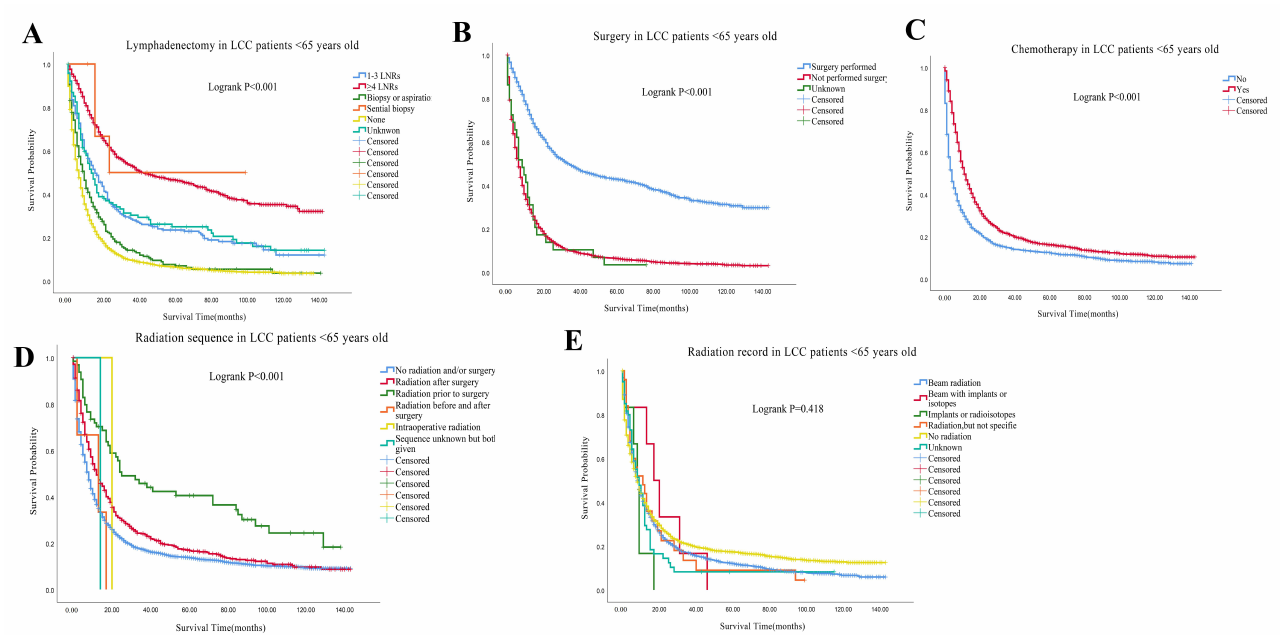
Figure 3. Comparison of survival curves of OS in different therapeutic subgroups of LCC patients <65 years old. ( A ) Comparison of lymphadenectomy subgroup; ( B ) Comparison of surgery sub- group; ( C ) Comparison of chemotherapy subgroup; ( D ) Comparison of radiation sequence subgroup; ( E ): Comparison of radiation record subgroup. Abbreviations: LCC: large cell carcinoma; LNRs: lymph nodes removed; OS: overall survival.